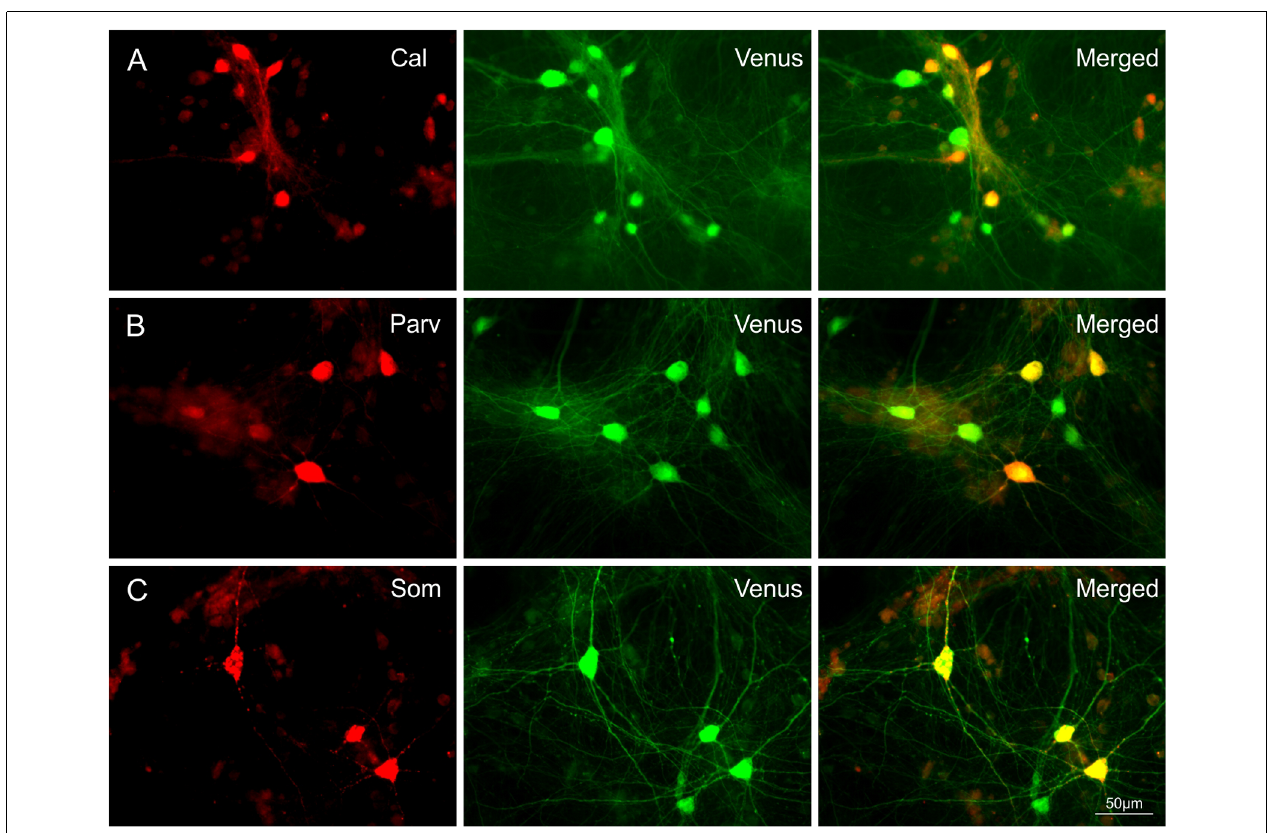
FIGURE 2 | Co-expression of Calretinin (Cal), Parvalbumin (Parv), or Somatostatin (Som) in Venus expressing neurons. Images show the co-localization of Cal (A) , Parv (B) or Som (C) with Venus in neurons of 28-day-old T25 networks. Differences in soma size between Figures 1 and 2 are due to age differences of the cultures at the time of fixation.